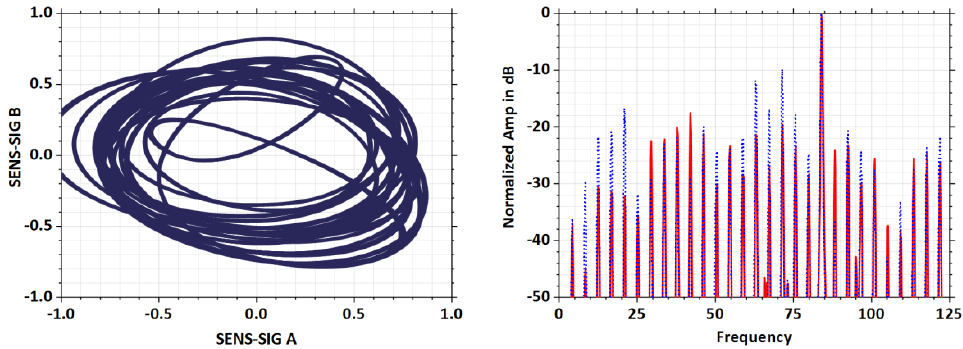
Figure 28. Outputs of a rotor R3 (multiple defected rotor bars).